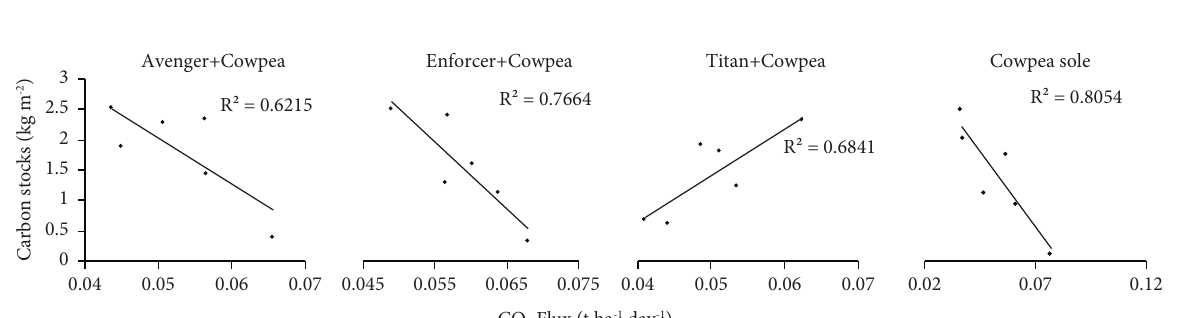
Figure 16: Carbon stocks ( y -axis) versus CO 2 emission rate ( x -axis) of sorghum and cowpea in binary and sole cultures at Syferkuil during the 2018/19 cropping season.